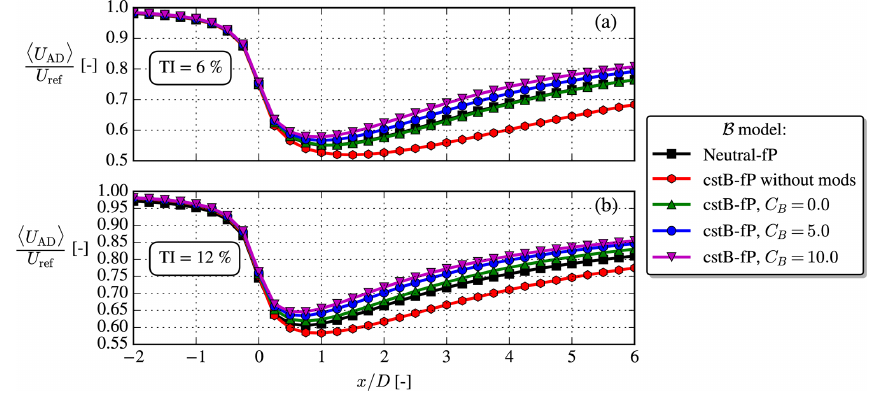
Figure 9. Same as Fig. 6, but with f P included. C B = { 0 . 0 , 5 . 0 , 10 . 0 } are tested for the unstable cstB model. Table 2. Overview of test cases. SWiFT: Doubrawa et al. (2020). NTK41: Machefaux et al. (2016). V80-Abkar: Abkar and Porté-Agel (2015). V80-Keck: Keck et al. (2014). NREL5MW: Churchfield et al. (2012). The air density used for all cases is ρ = 1 . 225kgm − 3